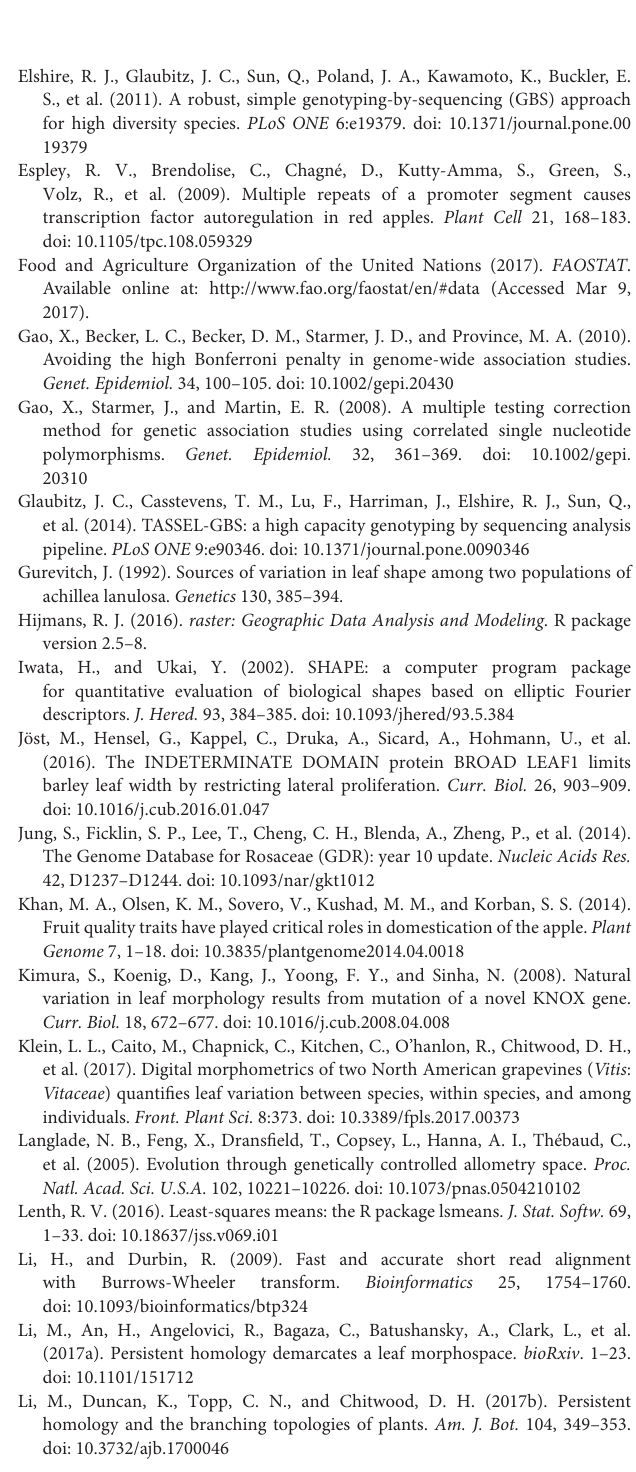
Table S8 | SNP heritability (h 2 ) for leaf phenotypes. h 2 represents the genetic variance (V g ) divided by the phenotypic variance (V p ). The standard error (SE) is also reported. These results are visualized in Figure 8